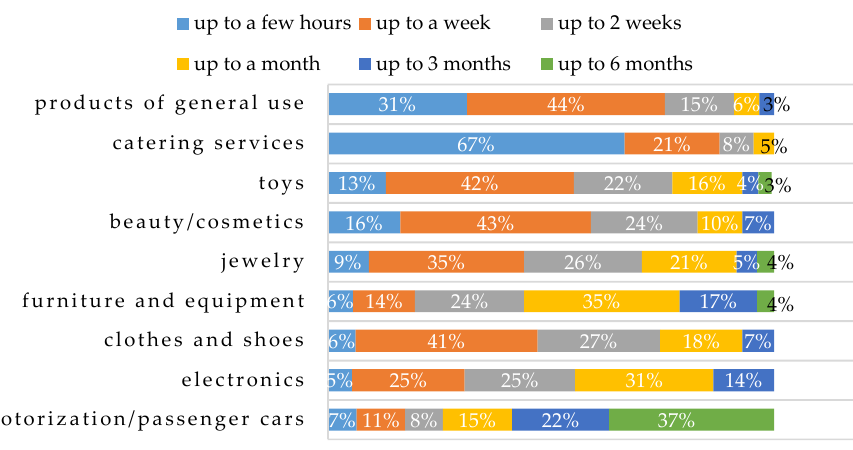
Figure 5. Acceptable waiting time for a personalized product. Source: own study.